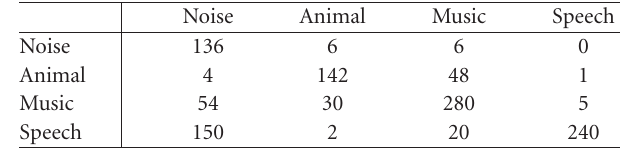
Table 7: Confusion matrix (rows give the decision and columns give the true class) for RSF short with GMM. This gave an accuracy of 70.99%.